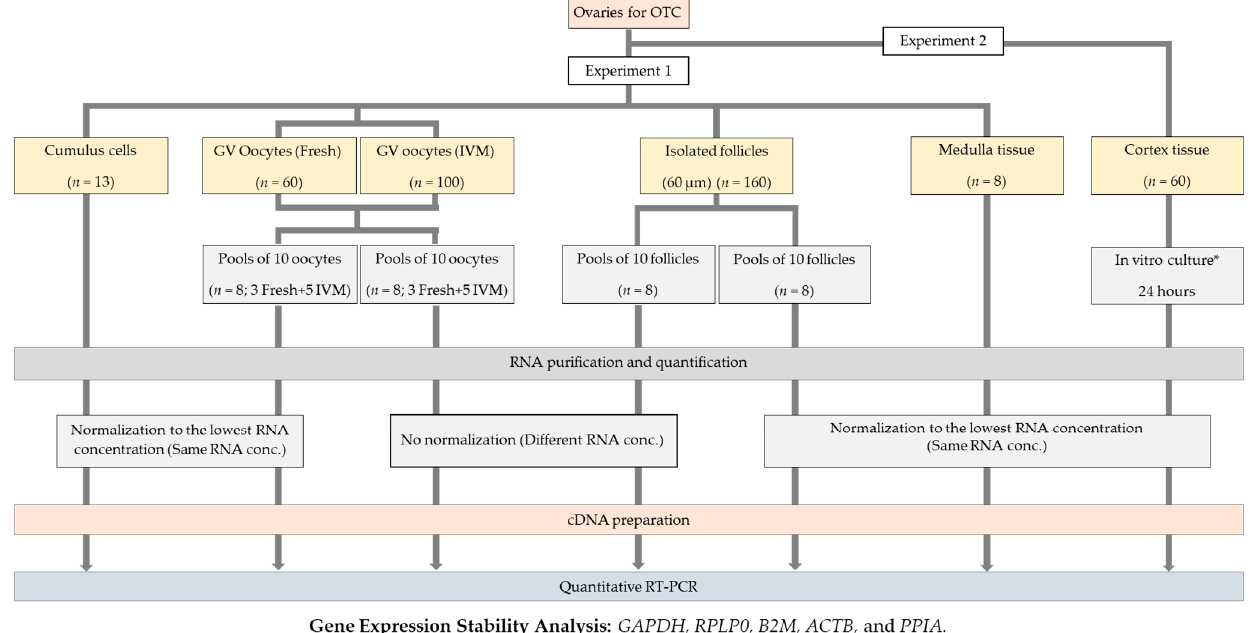
Figure 3. Experimental design. The stability of GAPDH , B2M , RPLP0 , ACTB , and PPIA was analyzed in different human ovarian cells and tissues by the NormFinder software. Two experiments were performed: In experiment 1, gene expression stability of the five RGs was analyzed in human oocytes, isolated preantral follicles, cumulus cells, and ovarian medulla tissue. In experiment 2, the stability of the five RGs was assessed in pieces of ovarian cortex after 24 h of culture in vitro under different conditions. Oocytes and follicles were subdivided into two groups depending on whether the RNA concentrations before cDNA synthesis were normalized or not, i.e., half of the samples had the same RNA concentration converted into cDNA (normalized), and the other half had a different RNA concentration within each sample converted into cDNA (not-normalized). The RNA concentrations in cumulus cells, ovarian medulla tissue, and ovarian cortex were all normalized. * Culture conditions for human ovarian cortex: base medium alone (Control treatment), base medium supplemented with 5 mg/mL HSA (HSA treatment), or base medium supplemented with increasing concentrations of PRP (5% PRP, 10% PRP, and 20% PRP